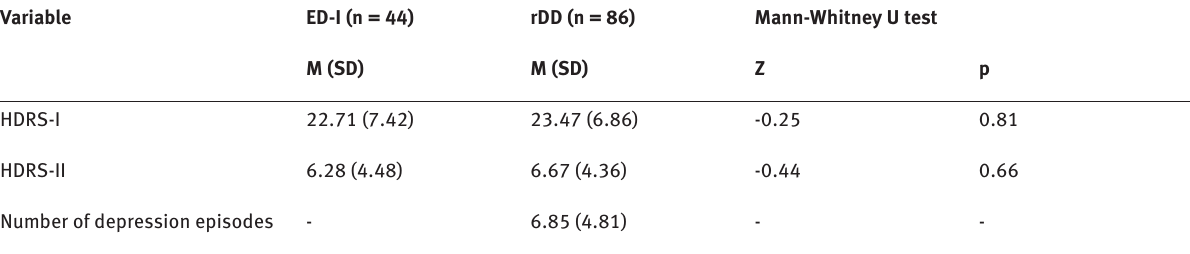
Table 2: The severity of depressive disorders among ED-I group and rDD group.